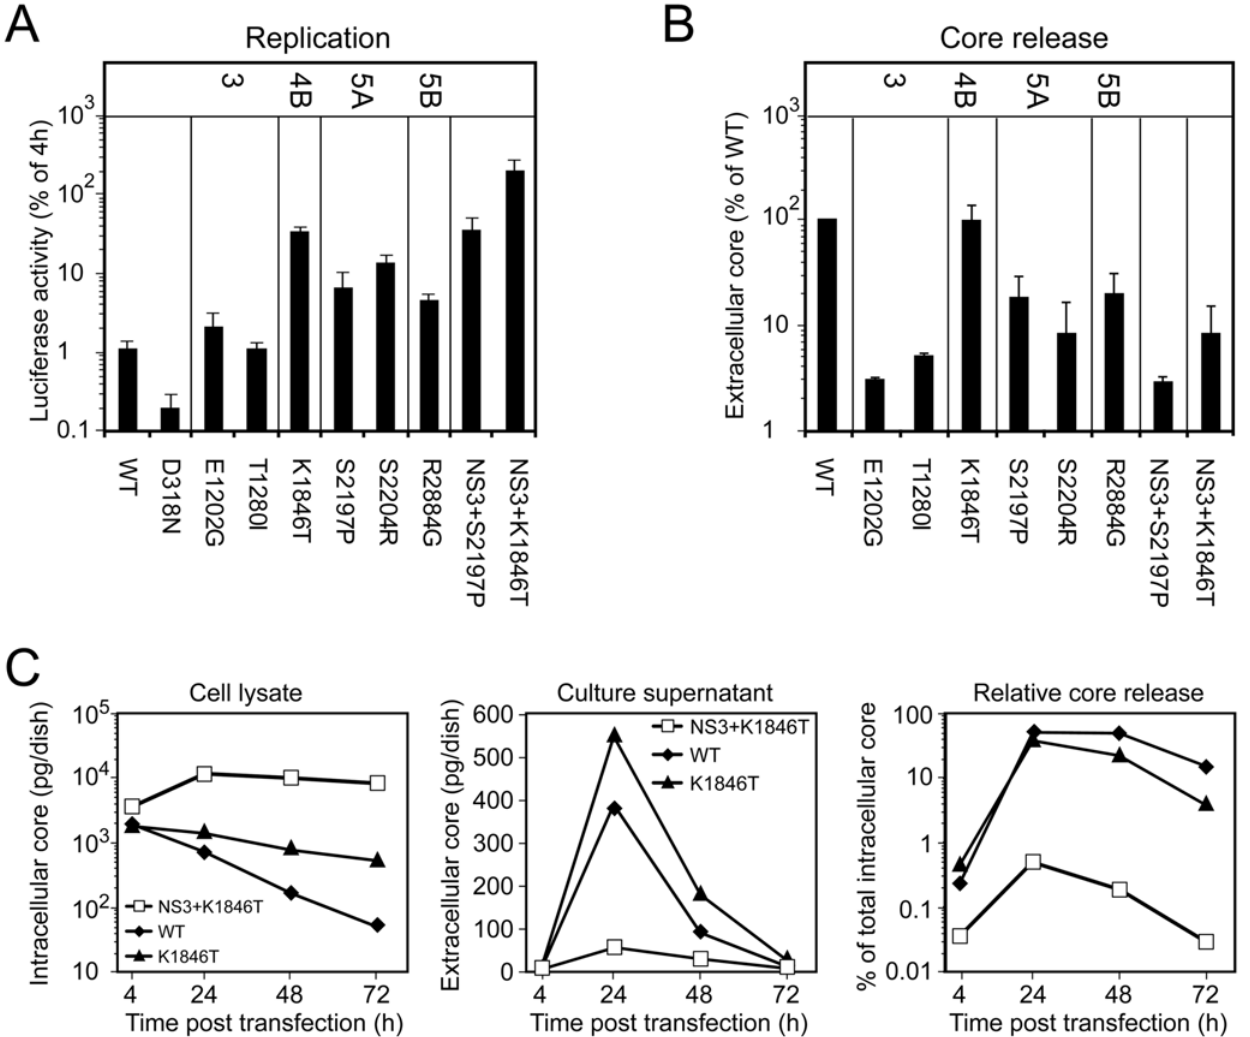
Figure 2. Impact of REMs on HCV particle release. (A) Replication of subgenomic luciferase replicons in transfected Huh-7 cells. The replication deficient replicon D318N served as negative control. Values refer to luciferase activities determined 48 h post transfection of Huh-7 cells after normalization for transfection efficiency determined 4 h post transfection. Data are taken from reference [17]. (B) Huh-7 cells were transfected with the Con1/wt genome or Con1 genomes carrying REMs specified in the bottom of the graph. The amount of core protein released into the supernatant 24 h after transfection was determined by using core ELISA and is expressed relative to the quantity of core measured for Con1/wt. Mean values of between 2 and 11 independent repetitions (depending on the construct) including the standard deviation are given. (C) Impact of REMs in NS4B and NS3 on RNA replication as determined by intracellular accumulation of core protein (left panel). The kinetic of release of core protein into the supernatant of Huh-7 cells after transfection with the Con1/wt or the Con1/K1846T or the Con1/NS3 + K1846T genome is shown in the middle panel. The right panel shows the percentage of intracellular core that is released into the culture supernatant of Huh-7 cells at various time points after transfection with each of the 3 genomes. A representative example of two independent repetitions is